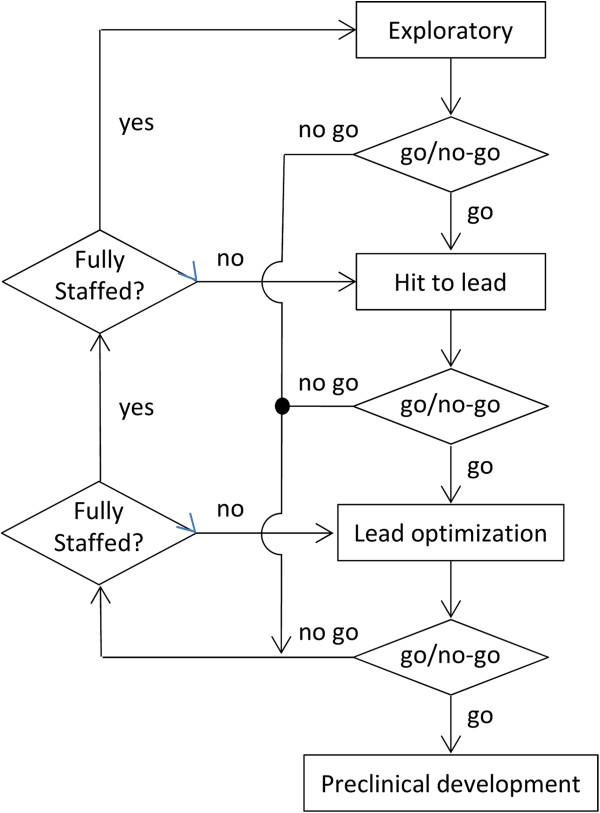
Decision flow chart of project milestone progression and scientist reassignment priority. Assignment of scientists to hit to lead projects is first to those on hold (if any) and second to any on-going understaffed efforts.